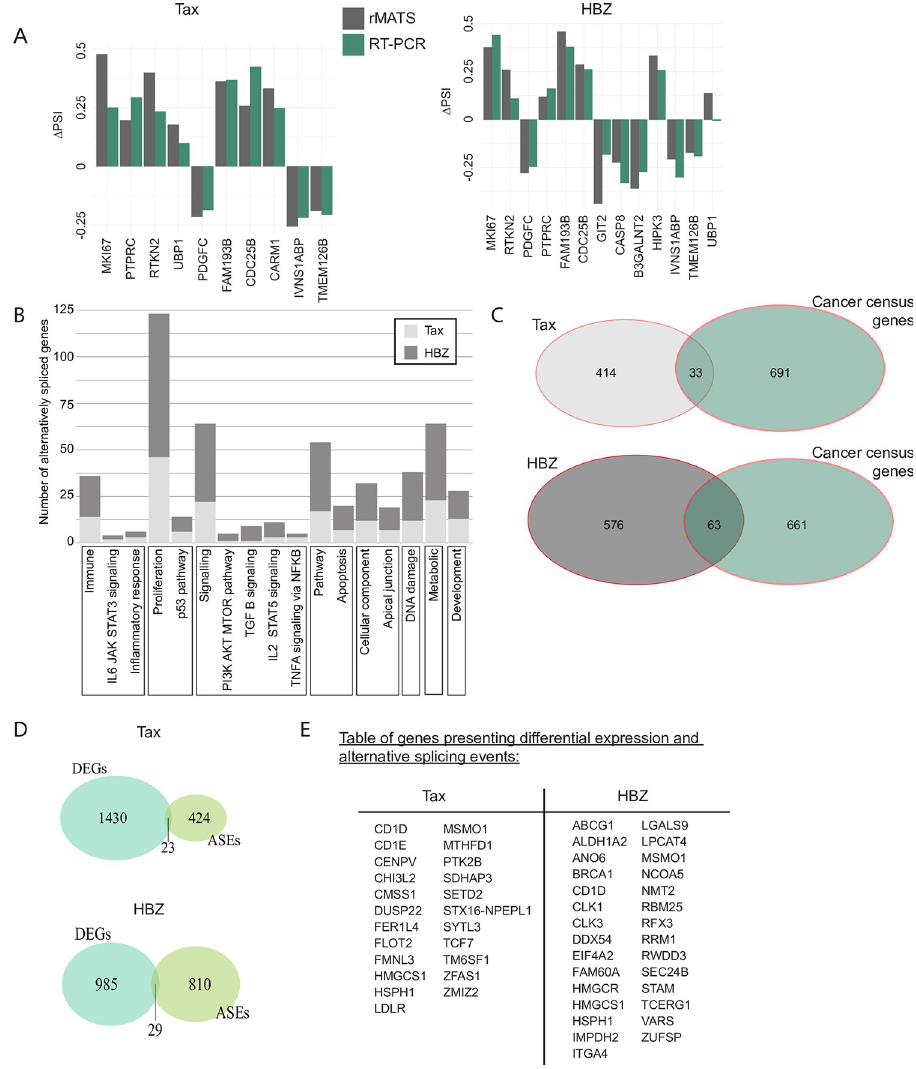
Fig 4. Splicing targets of Tax and HBZ are enriched for cancer related genes. (A) Validation of ASE events, 10 for Tax and 13 for HBZ, by RT-PCR. Graphs showing the Δ PSI experimentally determined by RT-PCR and the Δ PSI computationally obtained by rMATS for these events for Tax (left) and HBZ (right) (B) Alternatively spliced (AS) genes in iTax or iHBZ cells, which are part of a GSEA hallmark category. Cancer genes are in red. (C) Venn diagrams showing coverage of genes presenting ASEs in Jurkat iTax (top) or Jurkat iHBZ (bottom) cells with known cancer census genes. (D) Venn diagrams showing coverage between up- or down-regulated genes upon Tax or HBZ expression (blue) and genes with ASEs (green). (E) Table of genes with DE and AS in Tax or HBZ expressing cells See also S5 Fig and S3 Data.